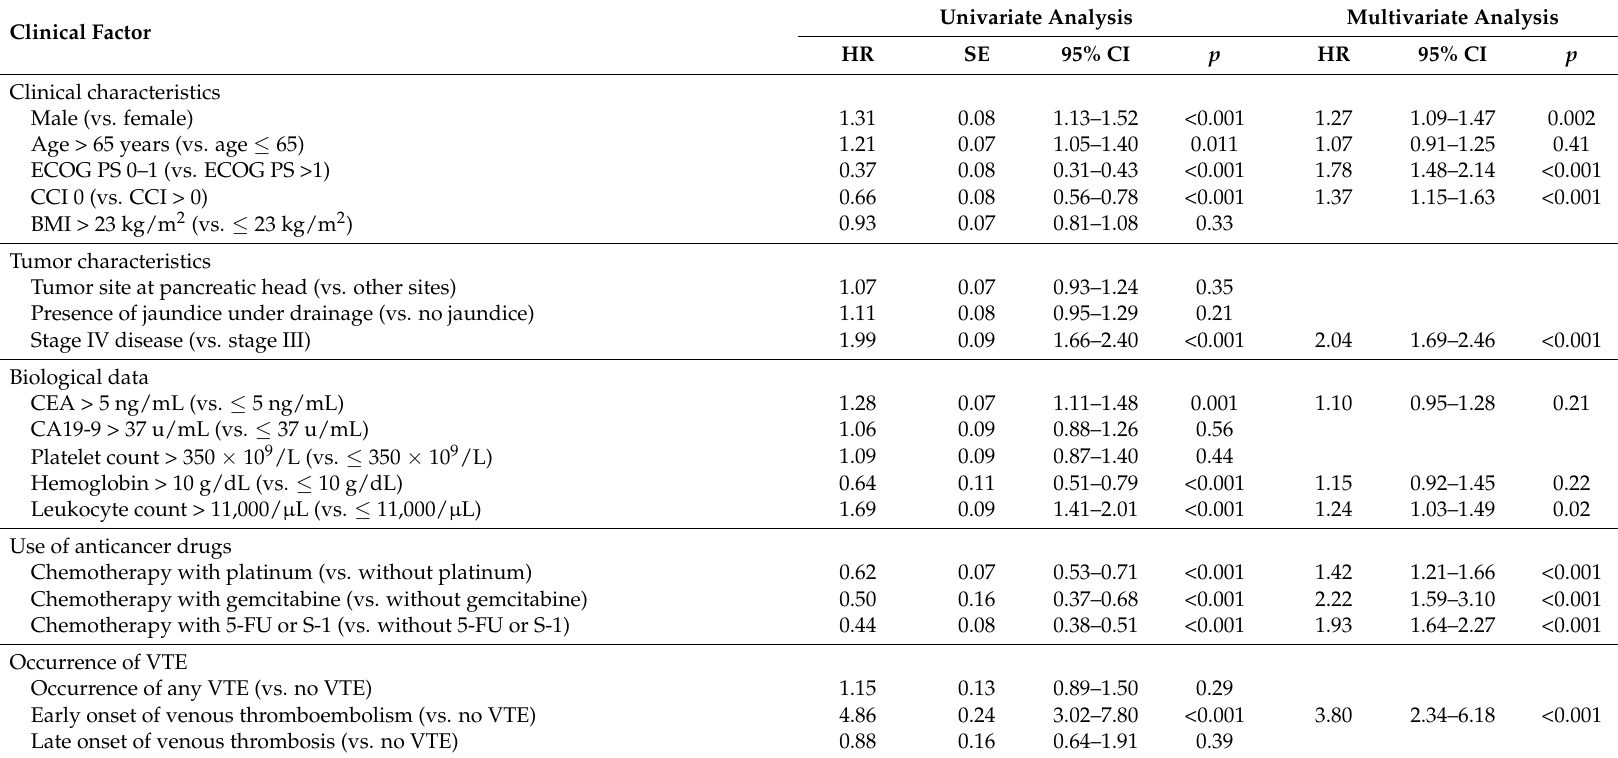
Table 5. Univariate and multivariate analyses of clinical factors for determining overall